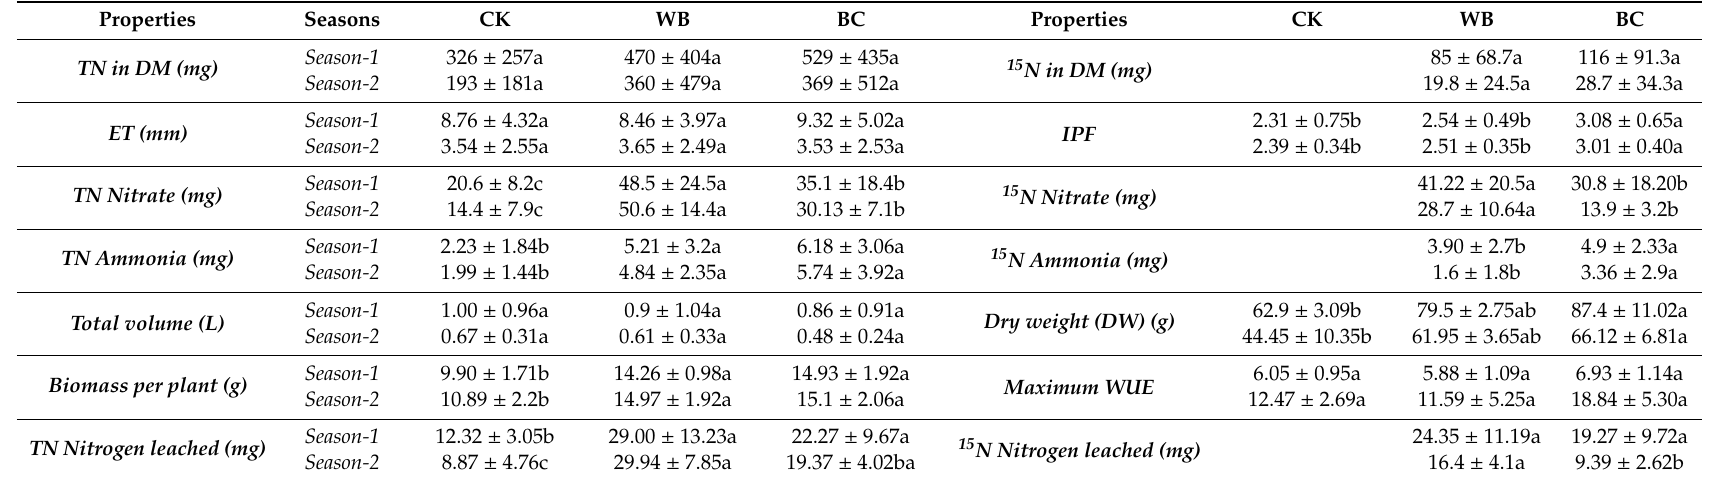
Table 1. Mean values with standard deviation for the parameters measured in each sampling date for the treatments; CK (control), WB (without biochar), and BC (biochar added) for the two cropping season of the Brassica Camprestis Var. Chinensis plantation in lysimeters. The small letters (a, b, c) present the level of significance among the treatments in a season according to the pairwise Sche ff e